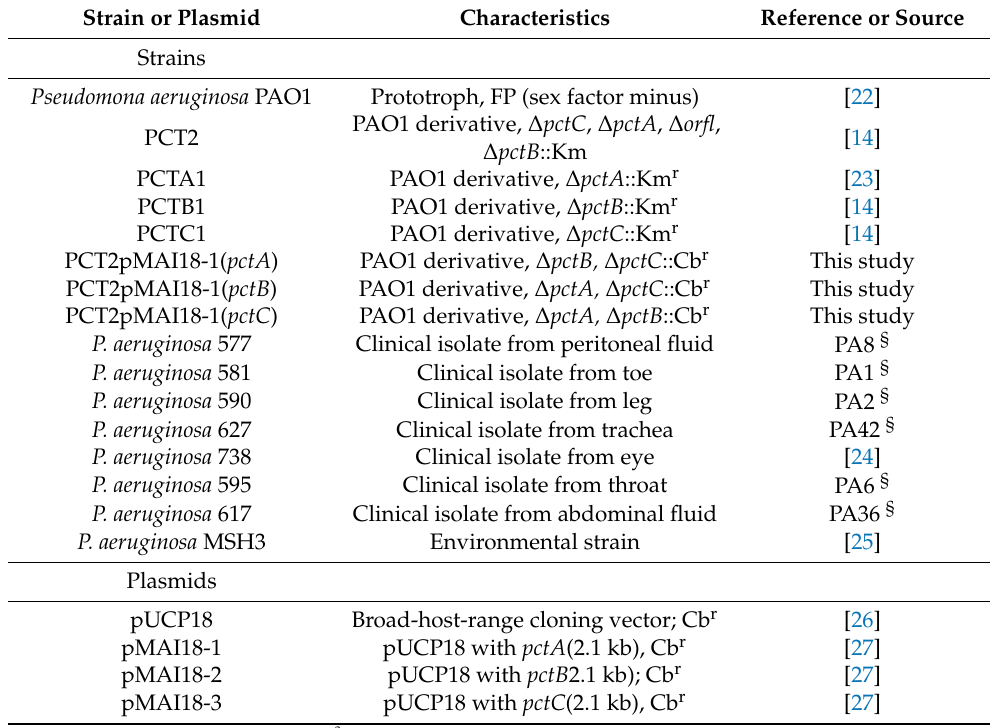
Table 1. Bacterial Strains and